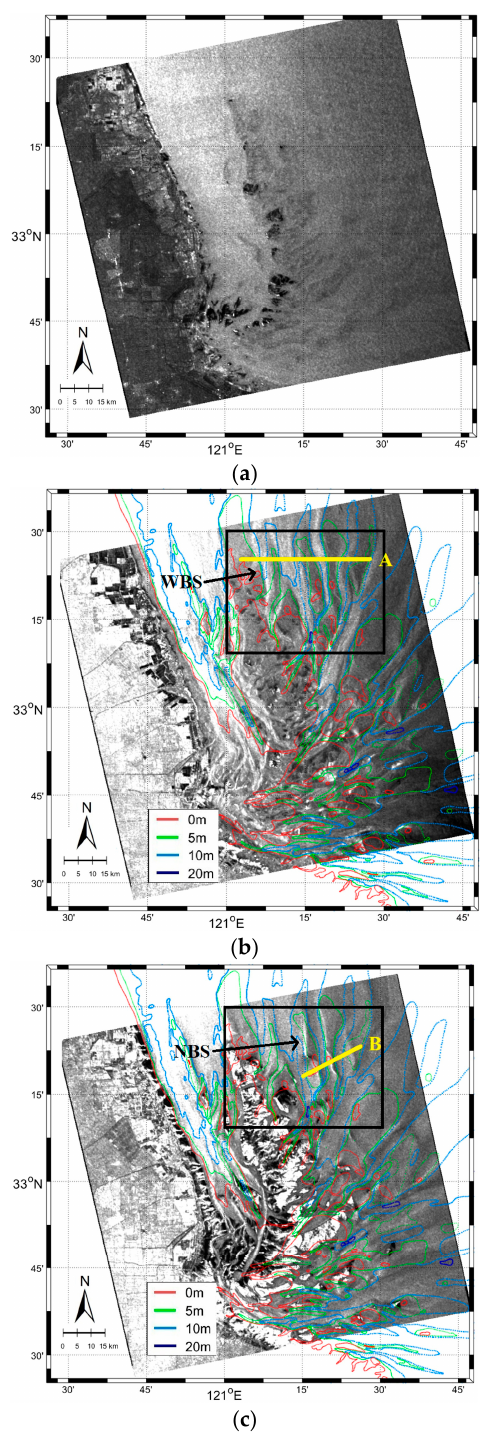
Figure 2. Examples of three typical ENVISAT ASAR images over Subei Bank: ( a ) image without any bathymetric features acquired at 13:45:32 UTC on 22 December 2008; ( b ) image with bathymetric features shown as wide bright stripes (WBS) in the small region denoted by the black rectangle, acquired at 13:45:29 UTC on 13 October 2008; ( c ) image with bathymetric features shown as narrow bright stripes (NBS) in the same region as ( b ), acquired at 13:45:28 UTC on 11 February 2008. The contours are water depth (m). The cross sections A and B (yellow lines, also shown as black lines in Figure 1b) are perpendicular to the paralleled bright stripes on SAR